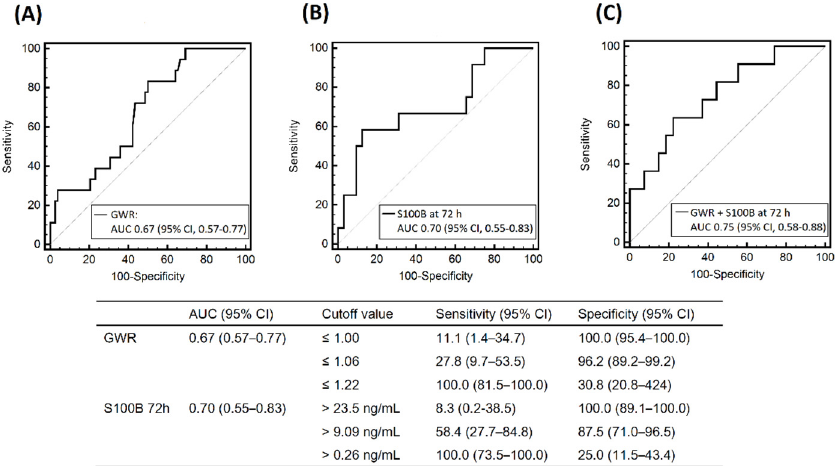
Figure 3. The receiver operating characteristic curves for evolution toward brain death after out-of- hospital cardiac arrest. ( A ) The AUC for GWR. ( B ) The AUC for the serum level of S100B protein at 72 h after cardiac arrest. ( C ) The AUC for the combined model with GWR and S100B at 72 h after cardiac arrest. AUC, area under the curve; CI, confidence interval; GWR, gray-to-white matter ratio at basal ganglia; S100B, S100 calcium-binding protein